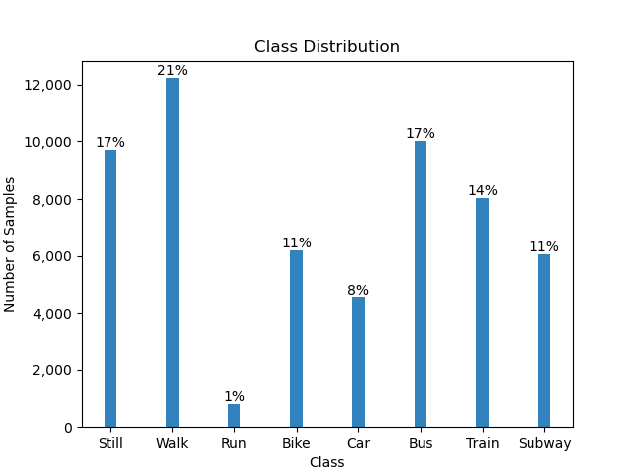
Figure 2. The histogram of the distribution of the labels in the challenge test set